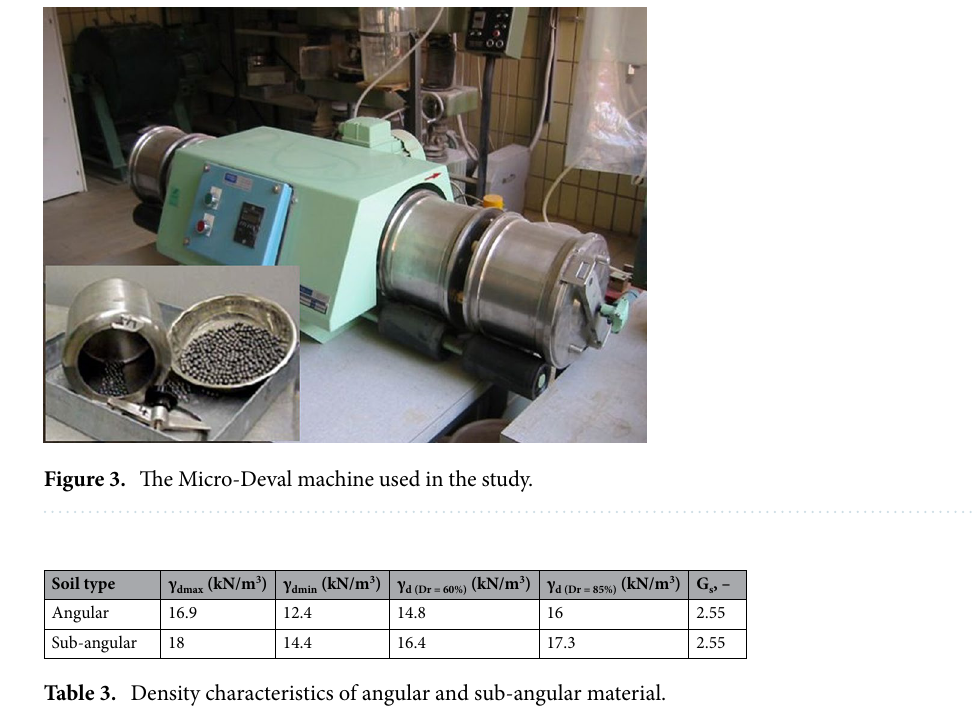
Table 3. Density characteristics of angular and sub-angular material.